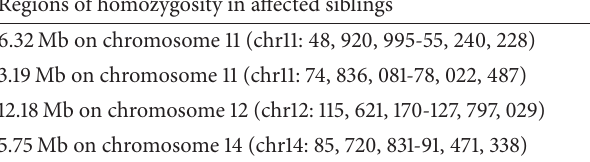
Regions of homozygosity in affected